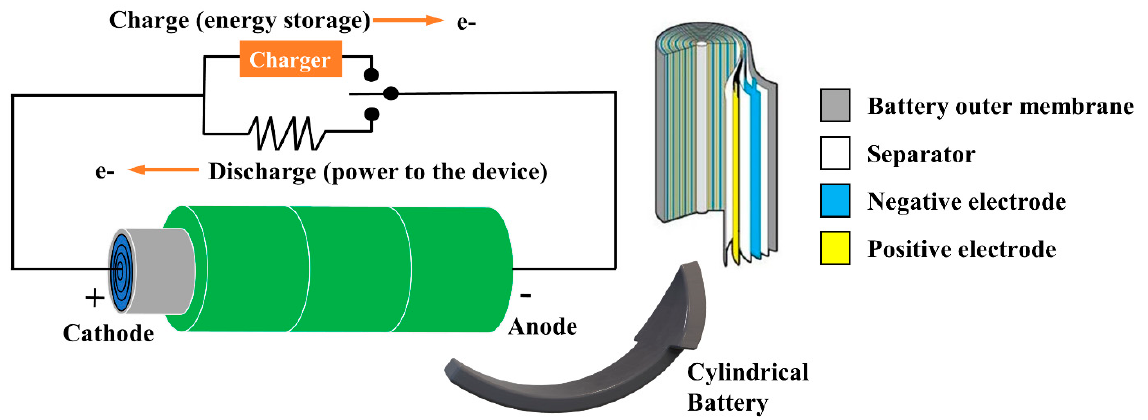
Figure 2. The principle of operation for a typical LIB and its structure.